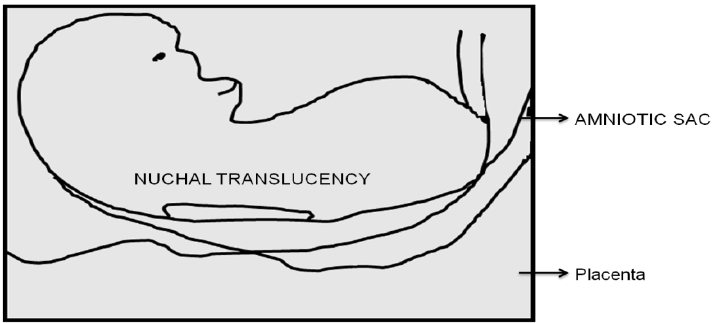
Figure 1. Identification of fetal nuchal translucency.